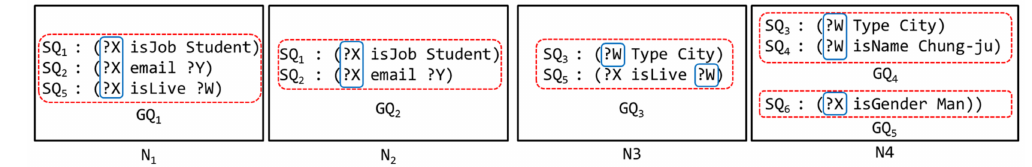
Figure 4. Grouping of subqueries by